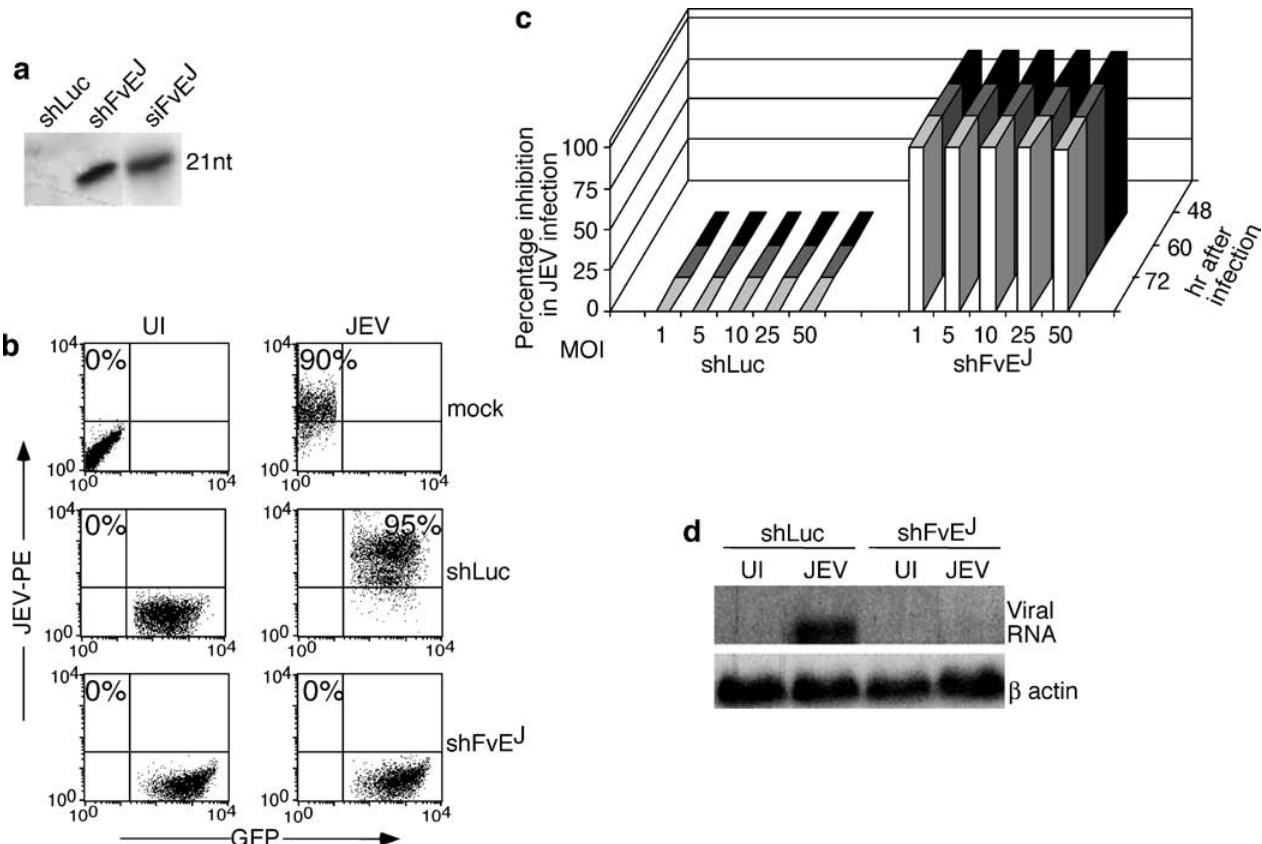
Figure 1. Lentiviral Delivery of FvE J shRNA Suppresses JEV Replication in Neuro 2a Cell